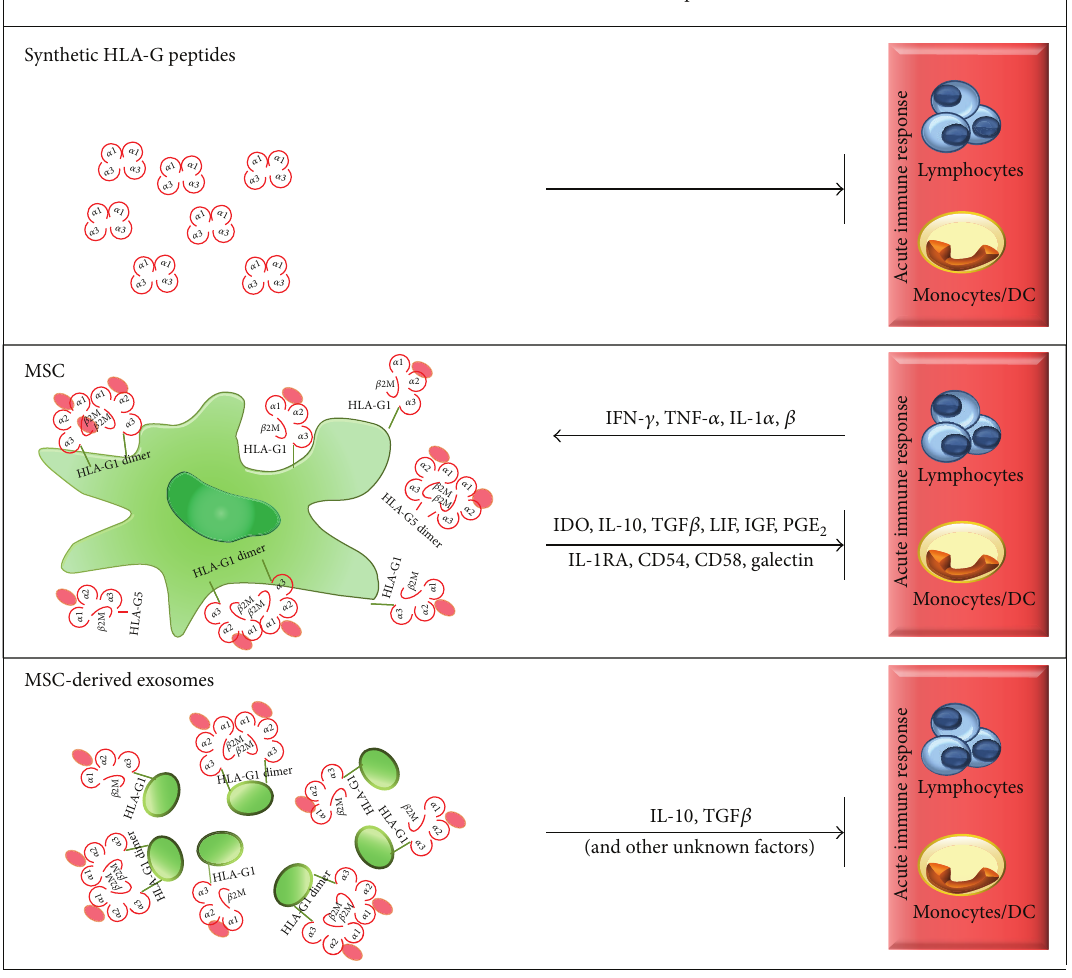
effects have been observed only in a portion of studies